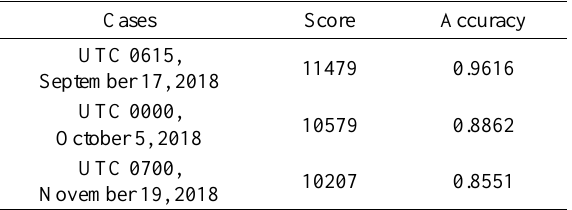
Table 10. Detection results of three